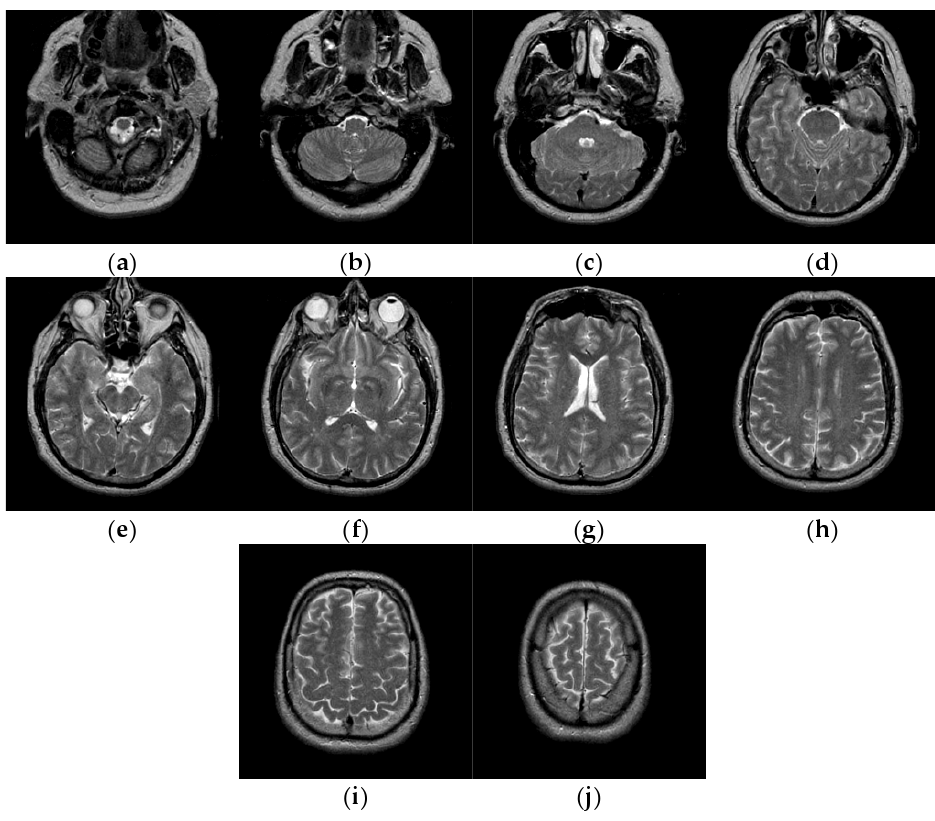
Figure 7. Ten brain slices ( a ) slice #022, ( b ) slice #032, ( c ) slice #042, ( d ) slice #052, ( e ) slice #062, ( f ) slice #072, ( g ) slice #082, ( h ) slice #092, ( i ) slice #102, ( j ) slice #112.